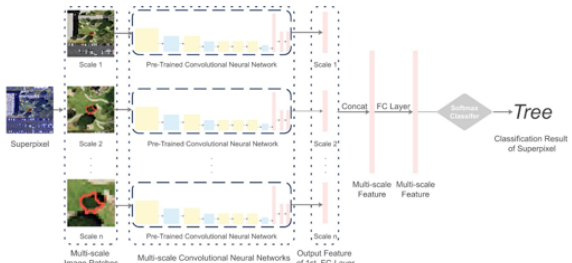
Figure 1. Framework of per-superpixel CNN method combining scale parameter estimation